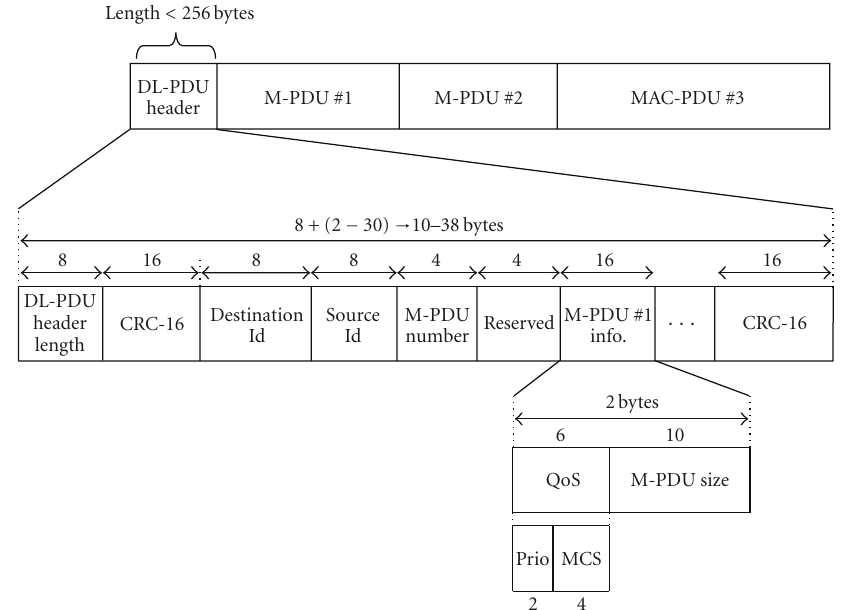
Figure 3: Bit-oriented implementation: example of UDP/IP